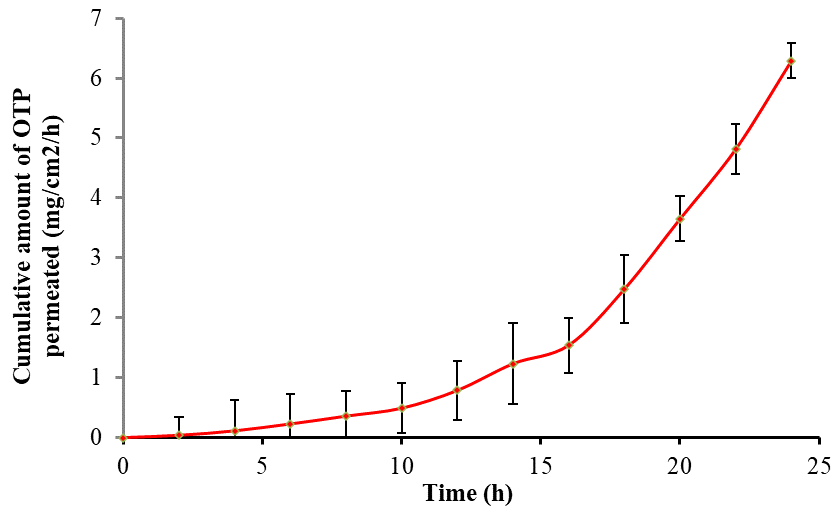
Figure 9. Ex vivo drug permeation plot for optimized transferosome-loaded proanthocyanidin.